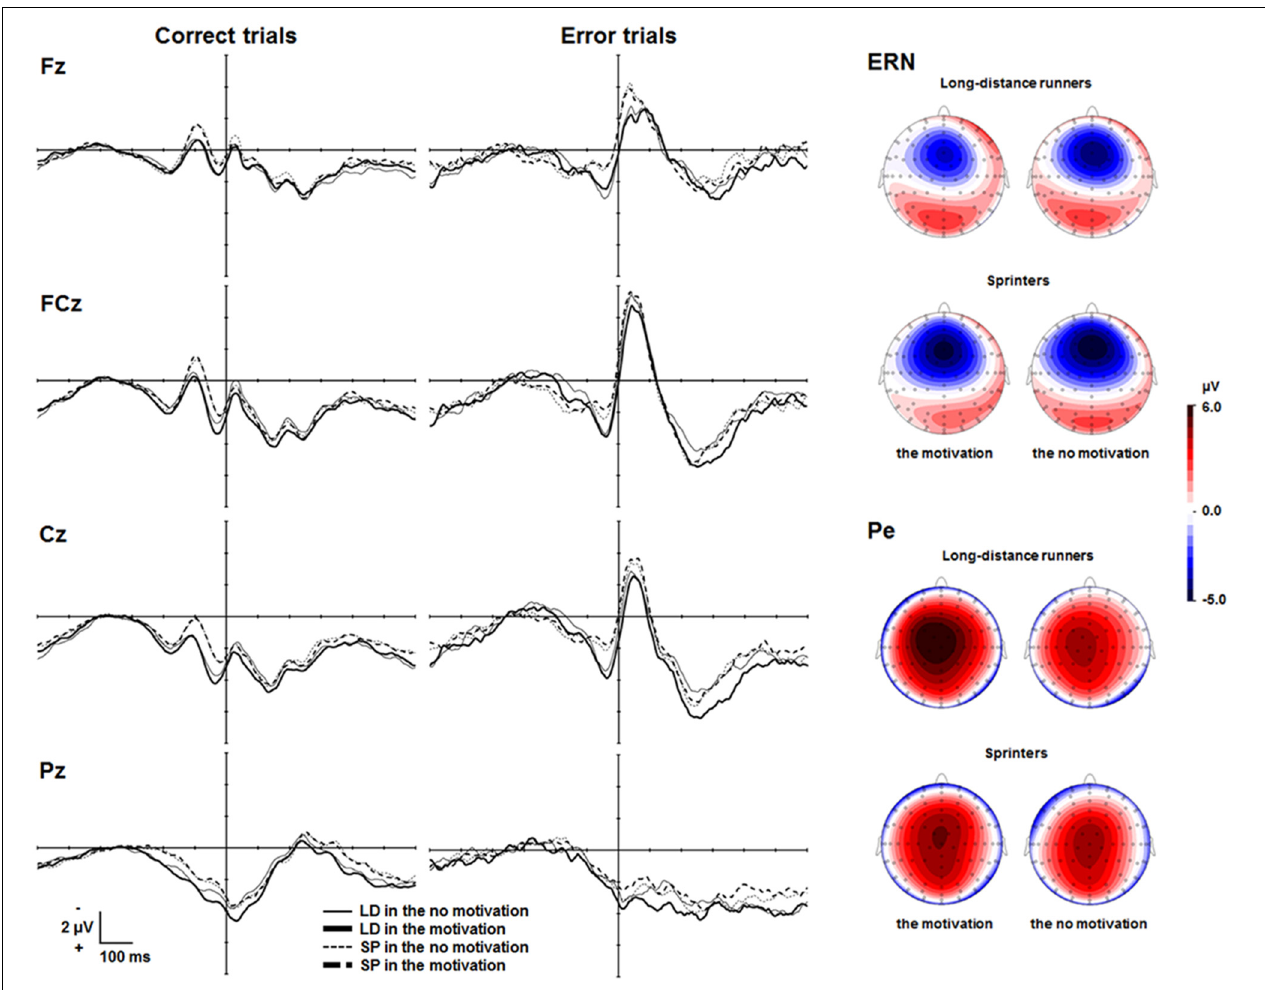
FIGURE 2 | Response-locked grand averaged waveforms on error and correct trials at Fz, FCz, Cz, and Pz. Topographies (only for illustrative purpose) represent brain activities during the time windows ranging from 25 to 75 ms for the Ne/ERN and ranging from 200 to 350 ms for the Pe, respectively. LD, long-distance runners; SP, sprinters. Response-locked grand averaged waveforms on correct trials are shown only for illustrative